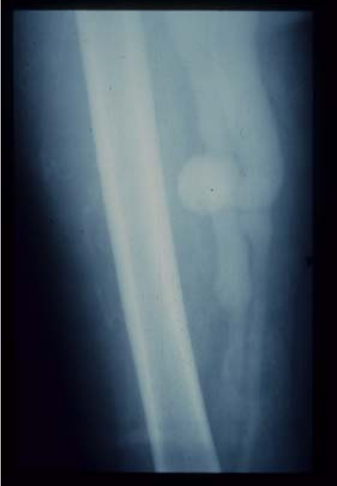
Figure 1: Angiogram showed the arteriovenous fistula at mid- superficial femoral artery and vein with large venous aneurysm next to fistula.